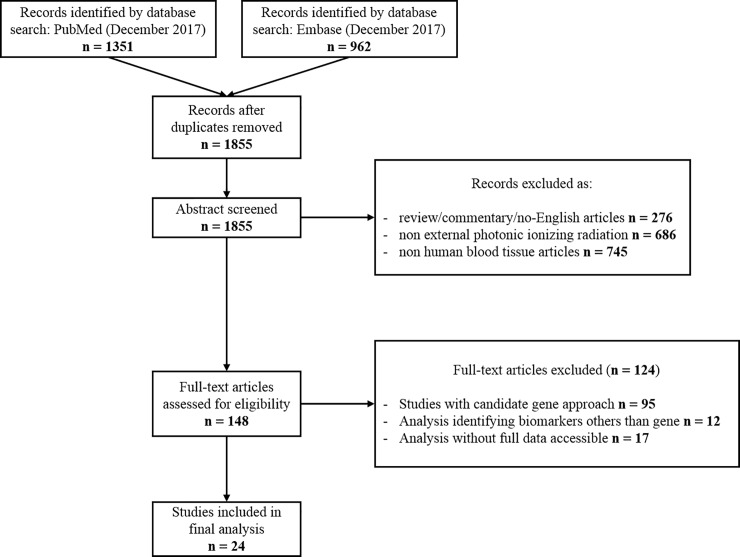
Flow diagram outlining the selection procedure to identify 24 articles that were included in the systematic review of gene radiation dosimetry biomarkers in human blood.